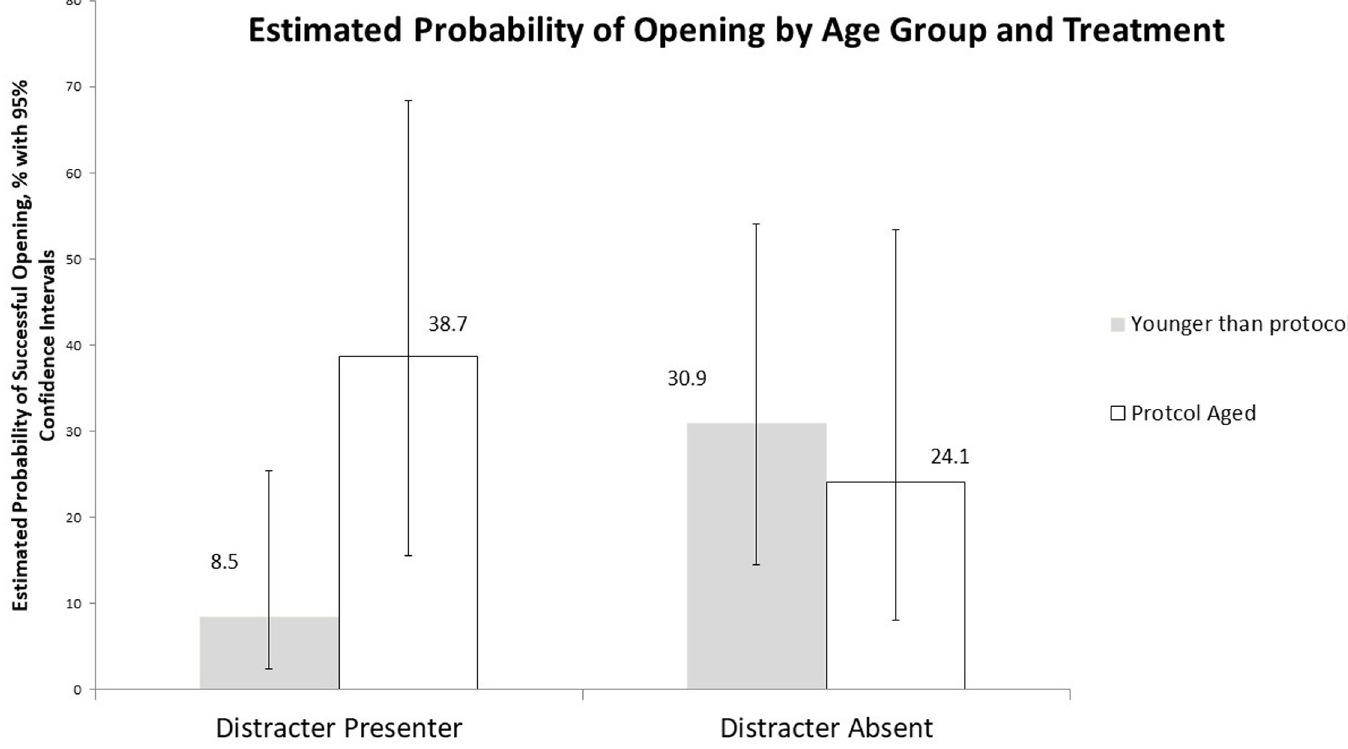
Fig 2. Estimated mean probability (and corresponding 95% confidence interval) of successful openings by age group for vials with or without visual distracters.